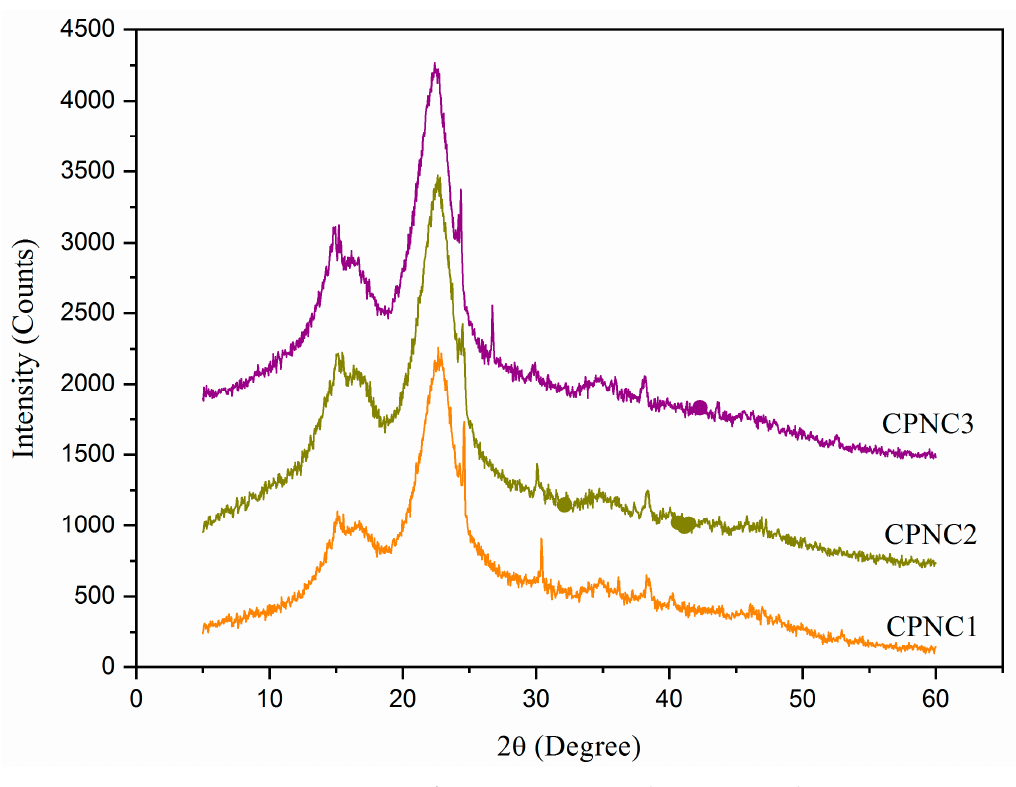
Figure 4. XRD spectra of CPNC1, CPNC2, and CPNC3 samples.